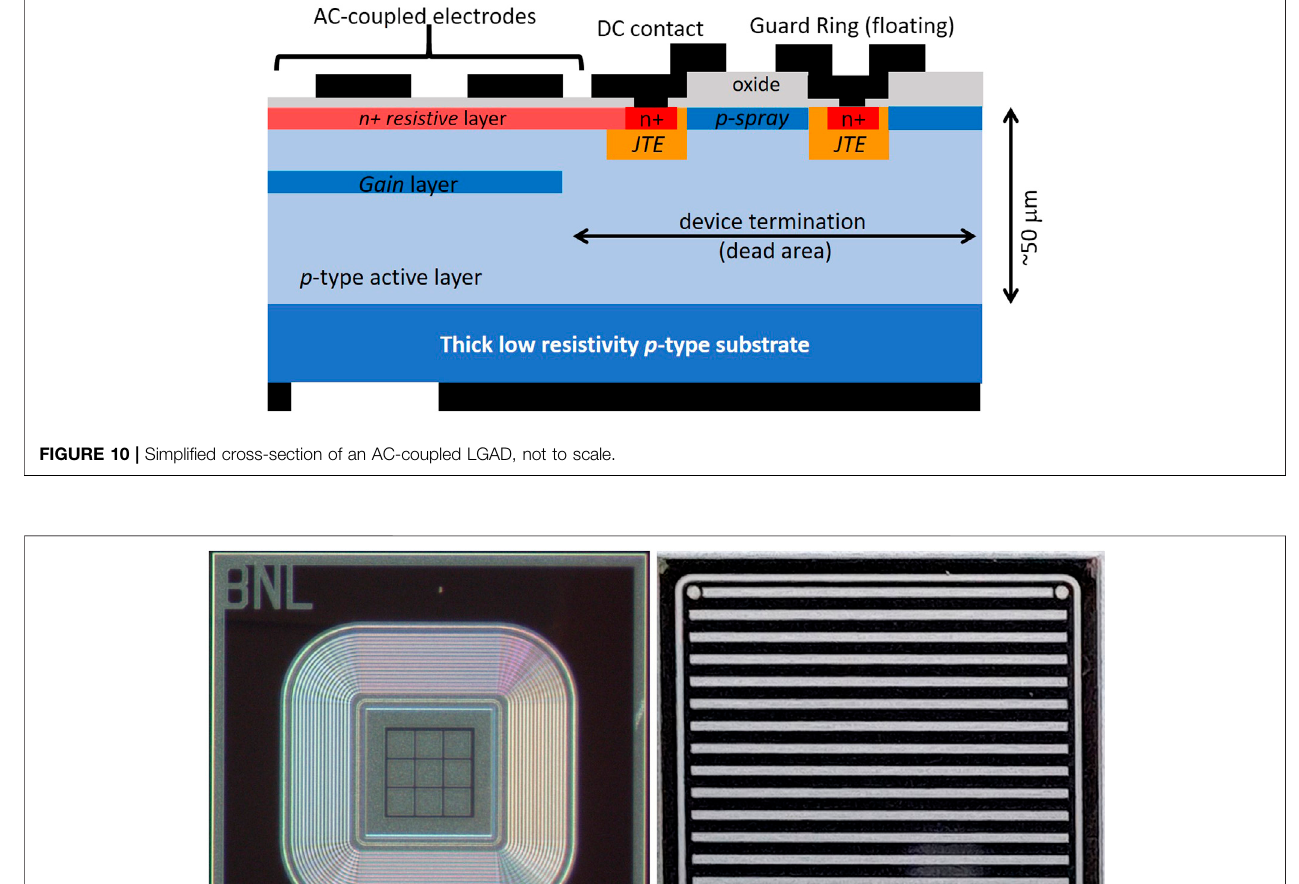
Frontiers in Physics |